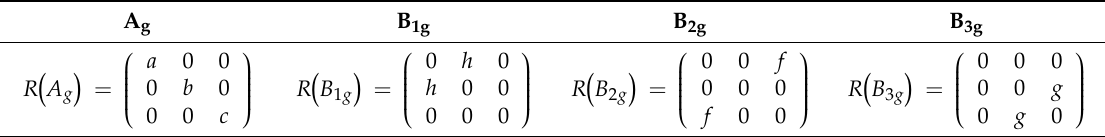
Figure 2. ( a ) Crystalline structure of black phosphorus, ( b ) atomic displacements of the Raman-active modes in black phosphorus. Table 1. Raman tensors of all active modes of black